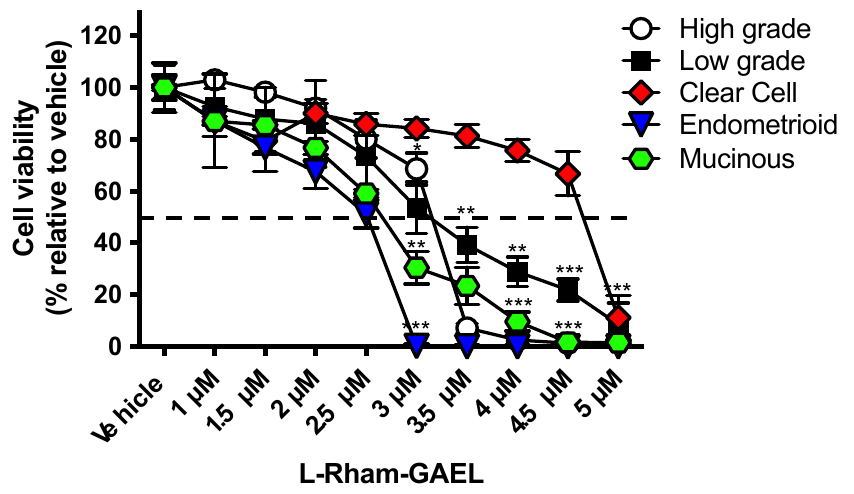
Figure 7. Primary patient EOC cell L -Rham sensitivity. Dose response to L -Rham for primary patient samples isolated from the ascites of patients representing each major EOC histotype. Vehicle = 0.9% saline. Cells were grown as a 2D adherent monolayer and exposed to L -Rham for 48 hours. The dashed lines indicate 50% cell viability. Data were obtained from 3 independent experiments with 6 data points per experiment. Vertical lines indicate standard deviation, and asterisks (*) indicate significant difference from vehicle-treated cells, [* < 0.05, ** < 0.01, *** < 0.001]; Kruskal–Wallis test with Dunn’s multiple comparisons per group was used to assess significance.